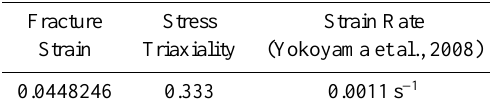
Table 2. Damage model data. Fracture